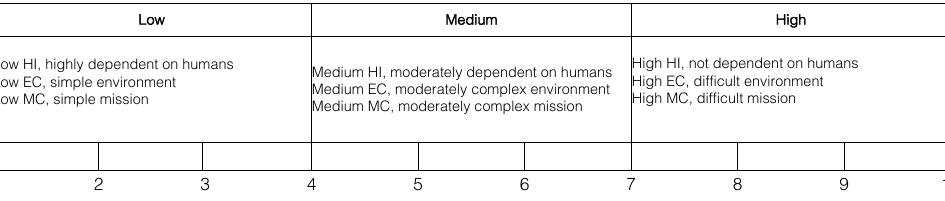
Figure 4. Human independence (HI), environment (EC) and mission (MC) complexities, mapped to a scale 1–10. Autonomy increases with scale.